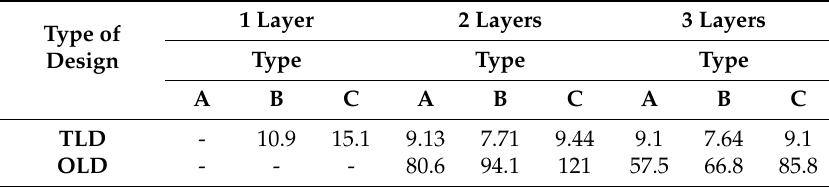
Table 6. Capacitance (pF) for OLD and TLD when 1–3 layers of D2070209P6 ink are used for mesh of 175